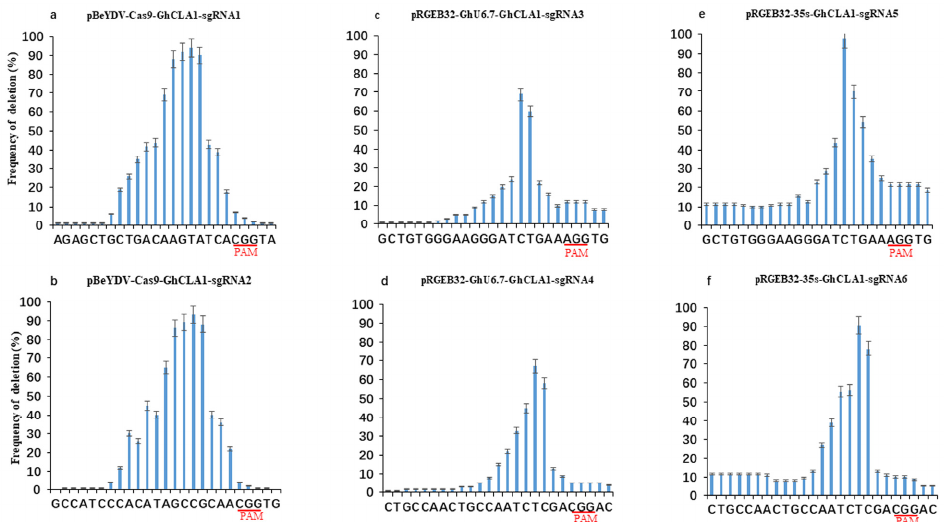
Figure 4. Comparison of positional deletion frequencies by three systems. ( a ): pBeYDV-Cas9- GhCLA1-sgRNA1. ( b ): pBeYDV-Cas9-GhCLA1-sgRNA2. ( c ): pRGEB32-GhU6.7-GhCLA1-sgRNA3. ( d ): pRGEB32-GhU6.7-GhCLA1-sgRNA4. ( e ): pRGEB32-35S-GhCLA1-sgRNA5. ( f ): pRGEB32-35S- GhCLA1-sgRNA6. PAM is underline. The experiments were carried out in cotton T0 plants and frequencies were measured by Hi-Tom sequencing.